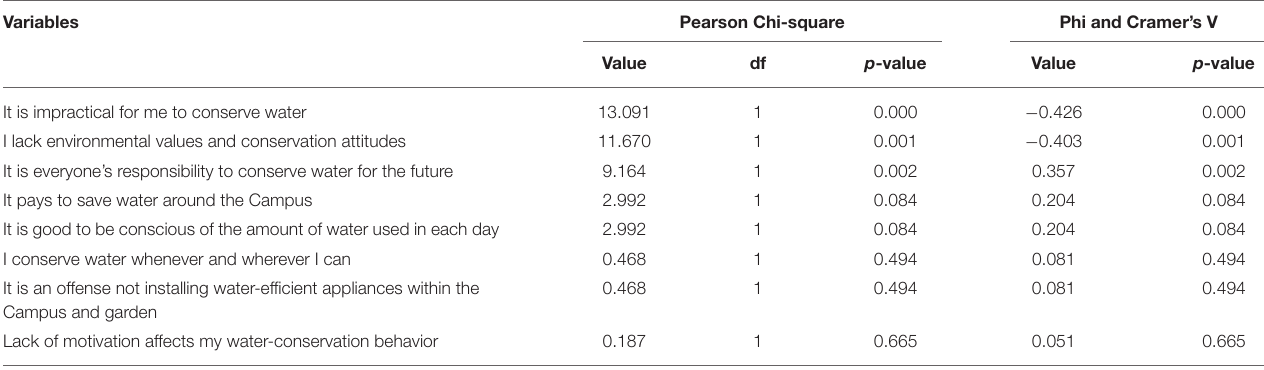
TABLE 2 | Correlation analysis—gender and water conservation motivation.